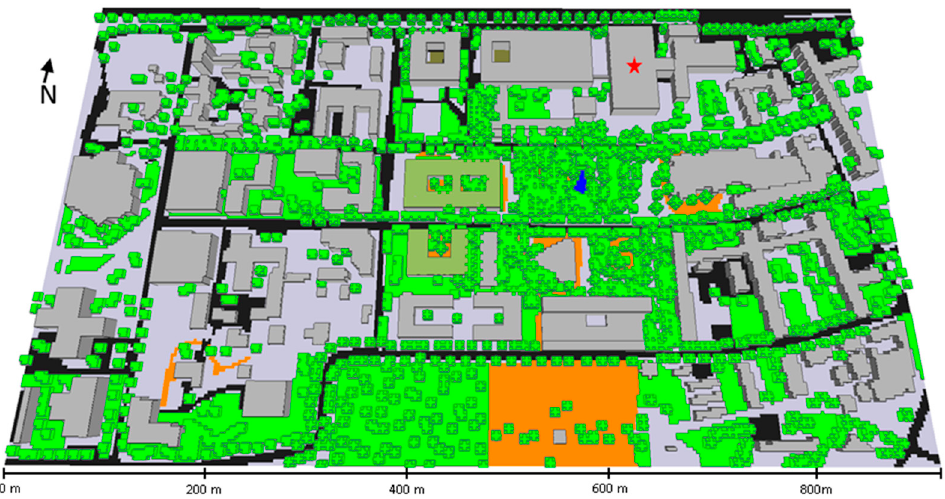
Figure 4. Model area for the realistic case simulation. Detector location is indicated by the red star.